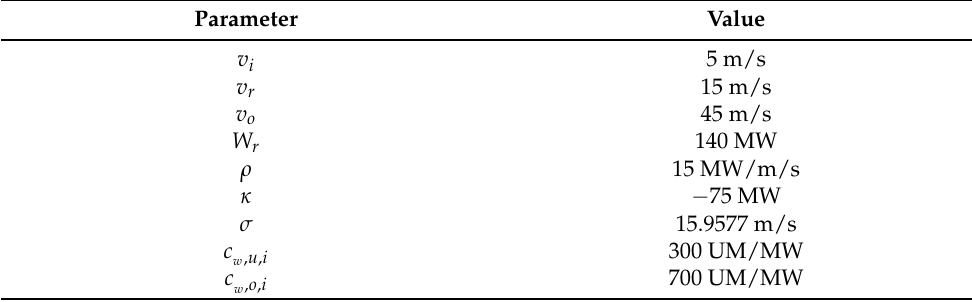
Table 9. Parameters taken for the cost function of the wind generator.